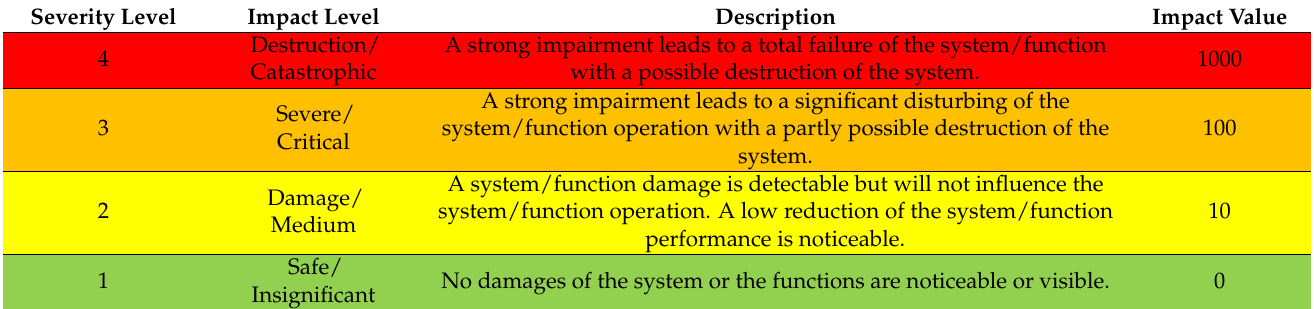
Table 20. Cybersecurity: severity (impact)